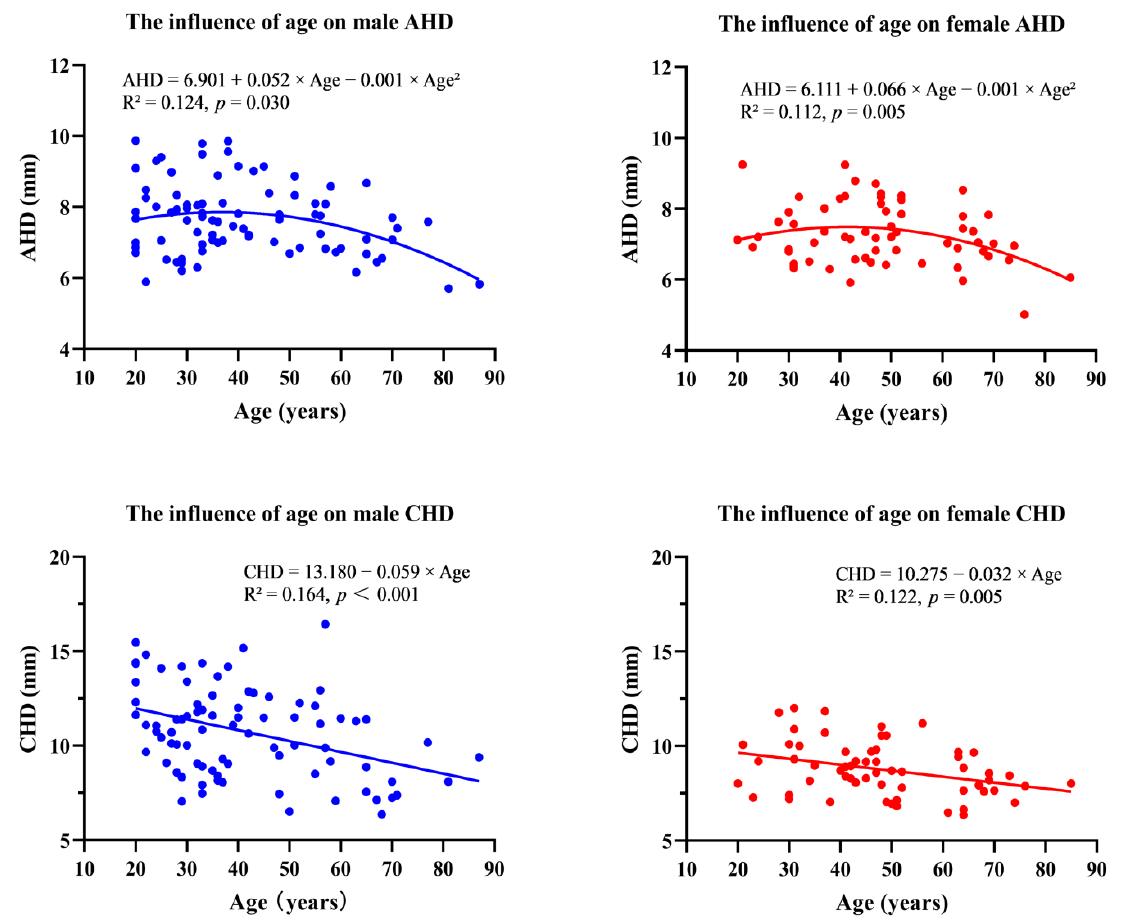
Figure 6. Curve correlation and Linear regression analyses of AHD and CHD. Curve correlation analyses representing the relationships between the CHD and ages in both sexes. Linear regression analyses representing the relationships between the CHD and ages in both sexes. AHD acromio- humeral distance, CHD coracohumeral interval.